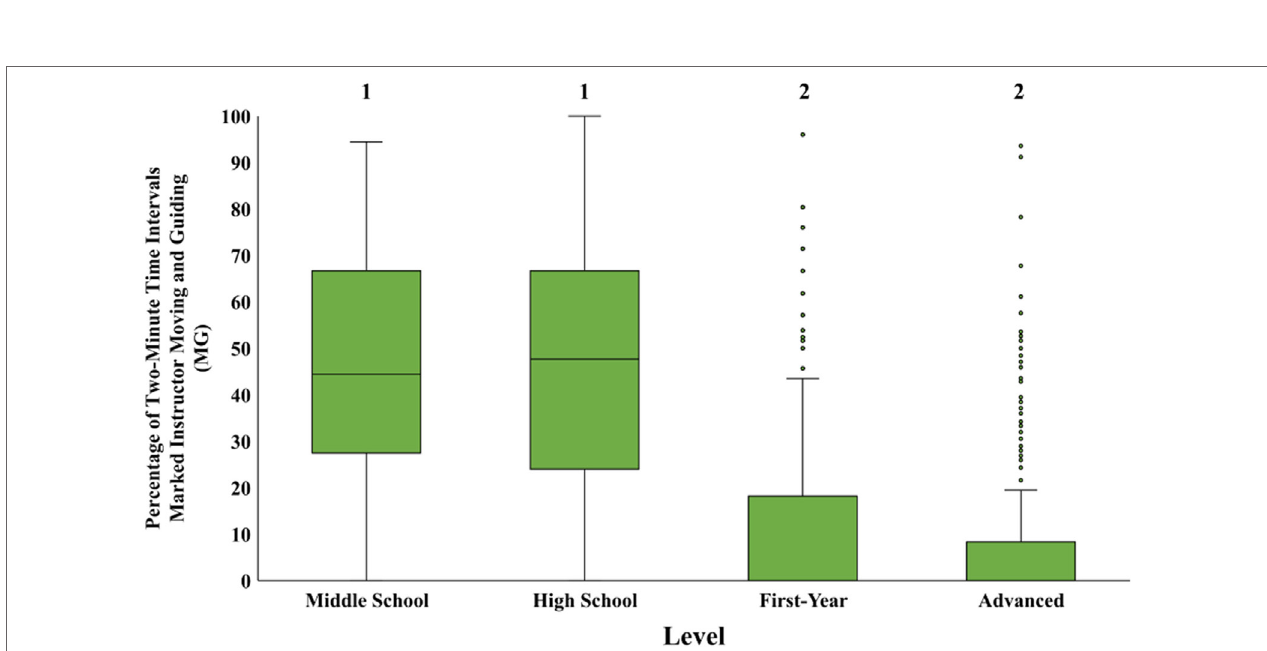
FigUre 5 | Comparison of the relative frequency of the Classroom Observation Protocol for Undergraduate STEM code Instructor Moving and Guiding (MG) for middle school, high school, first-year university, and advanced university class sessions. Box-and-whisker plots showing the median and variation between the four instructional levels. The line in the middle of the box represents the median percentage of 2-min time intervals for the class sessions in each level. Boxes represent the interquartile range, whiskers represent 1.5 times the interquartile range, and data points not included in 1.5 times the interquartile range are shown with dots. Levels labeled with different numbers indicate a significant difference between mean ranks by a post hoc Dunn’s pairwise comparison (Kruskal–Wallis Test, χ 2 = 169.56, df = 3, N = 482, p < 0.001; Dunn’s pairwise comparisons, p < 0.001 for levels labeled with different numbers).